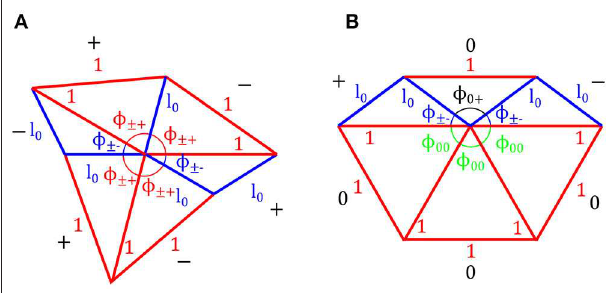
0.6180, ≈ π 2 π and φ . Note that any three 5 5 ±+ = ±− =